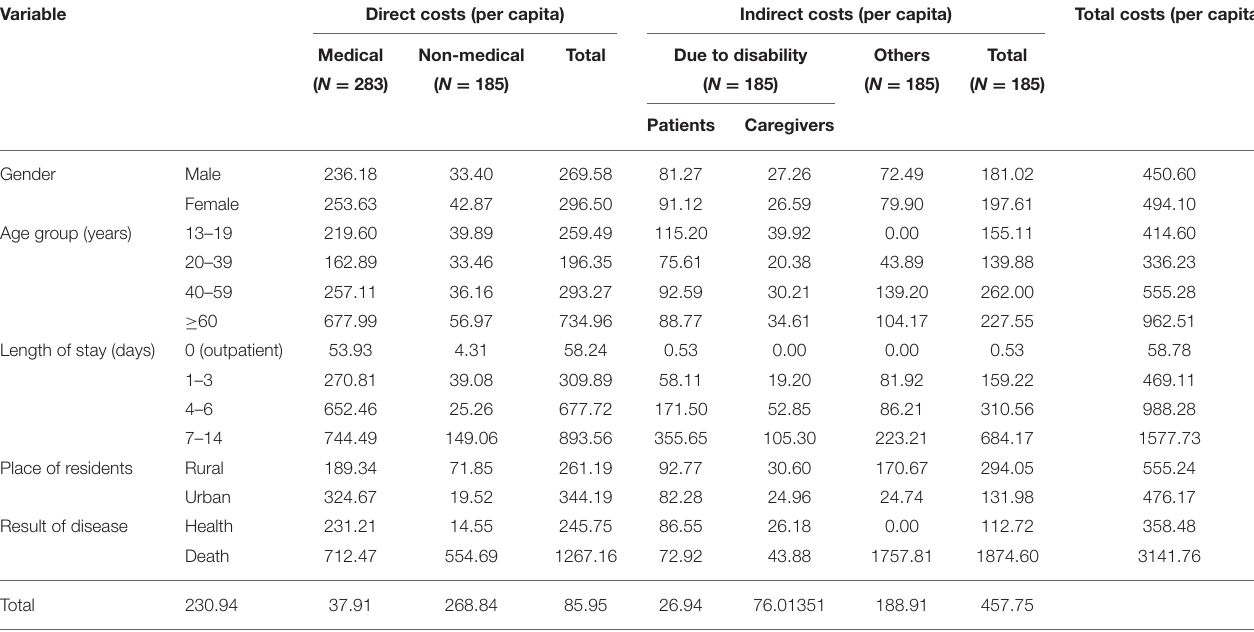
TABLE 3 | Per capita, direct, and indirect costs of poisoning with mushrooms by different characteristics of the patients in Kermanshah province, 2018. Variable